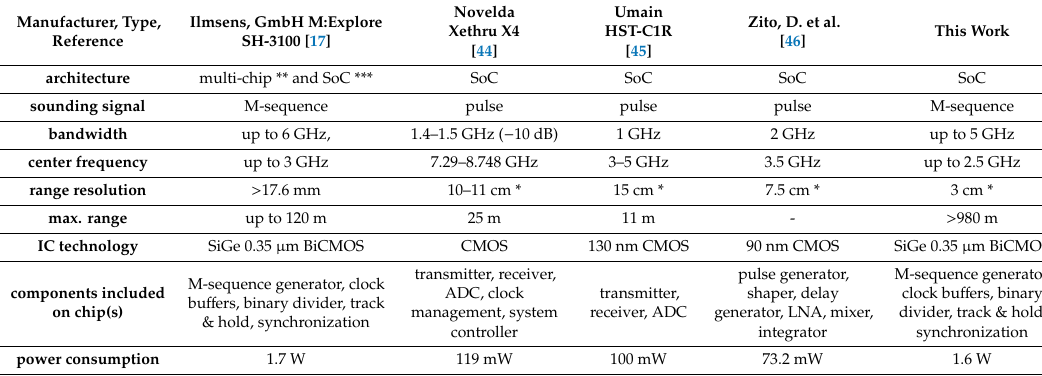
Table 1. Overview of application-specific integrated circuit (ASIC)-based ultra-wideband sensors (UWB) radars. SoC: system on